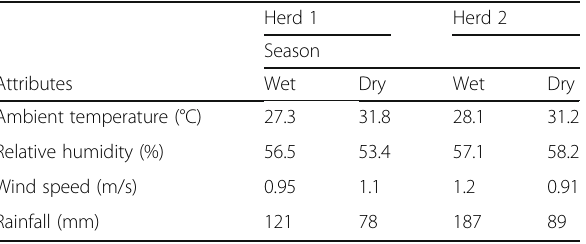
Table 1 The weather conditions during the trial period at the two farms occupied by the Boran and Nguni